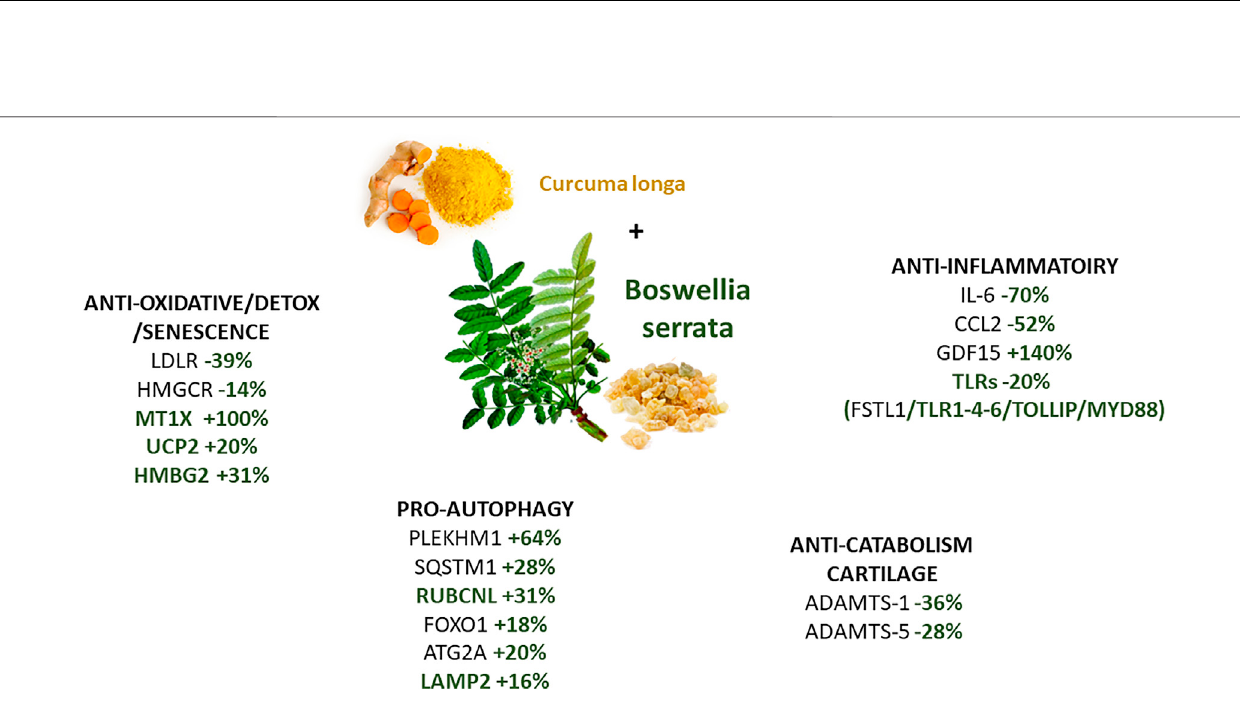
Frontiers in Pharmacology |